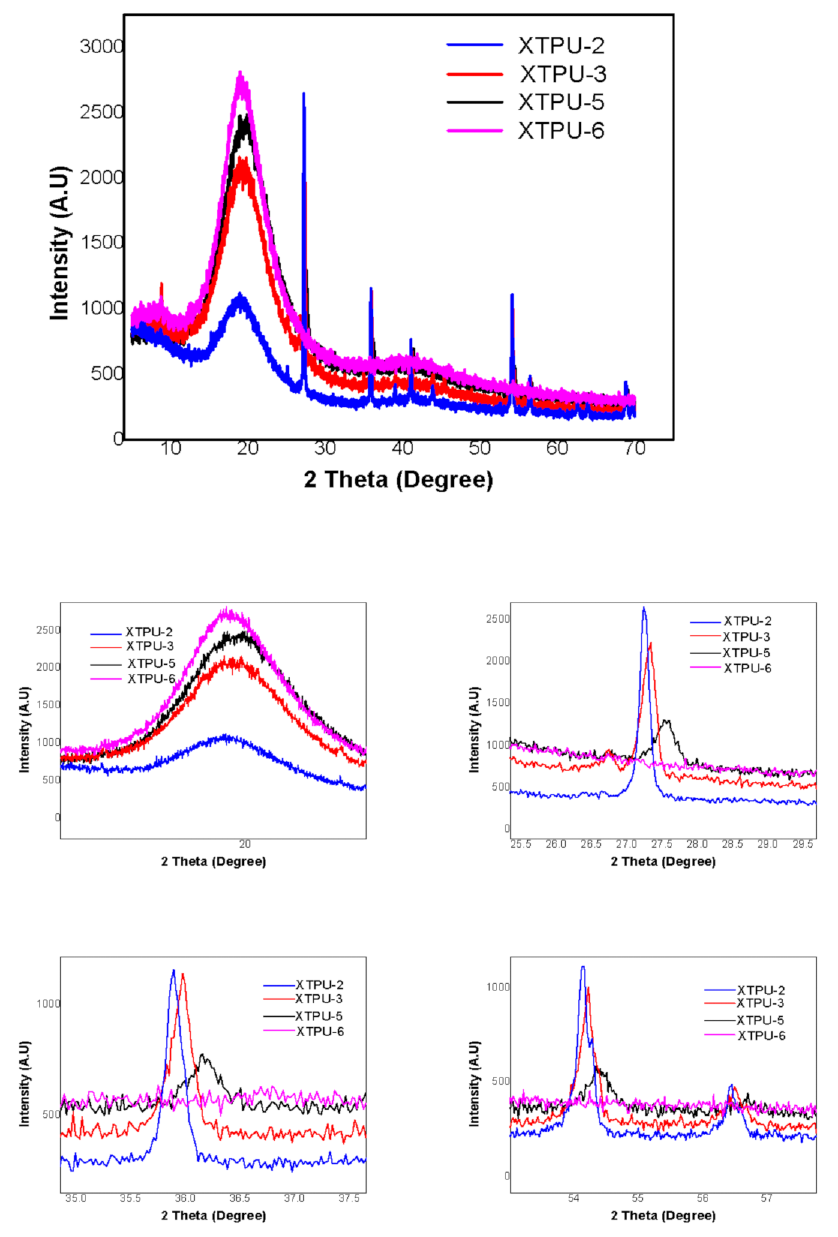
Figure 8. X-ray diffractograms of XTPU-2, XTPU-3, XTPU-5, and XTPU-6 with varying titanium dioxide %